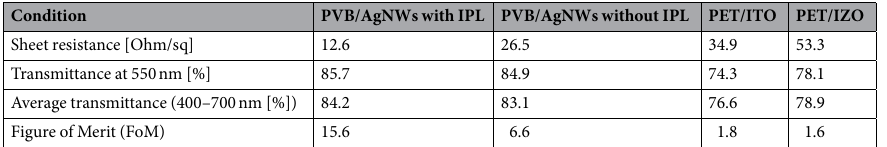
Figure of Merit